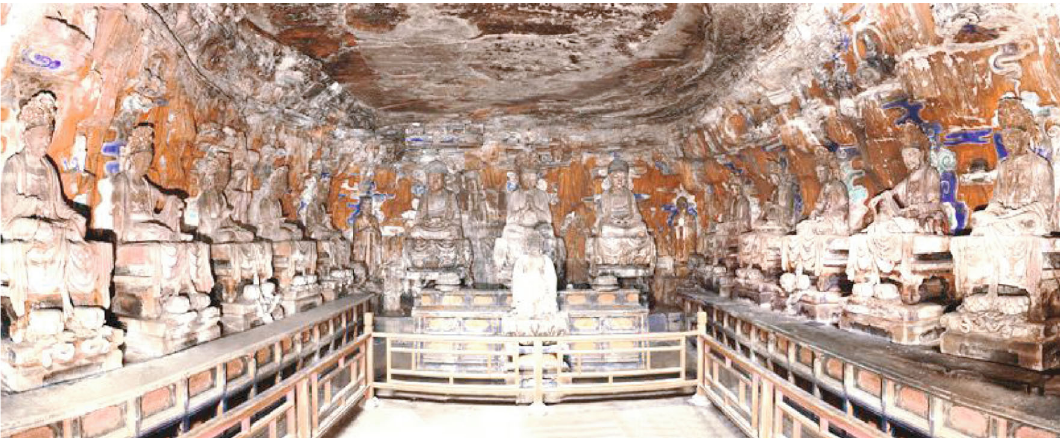
Figure 1: Shape of the internal Buddhist